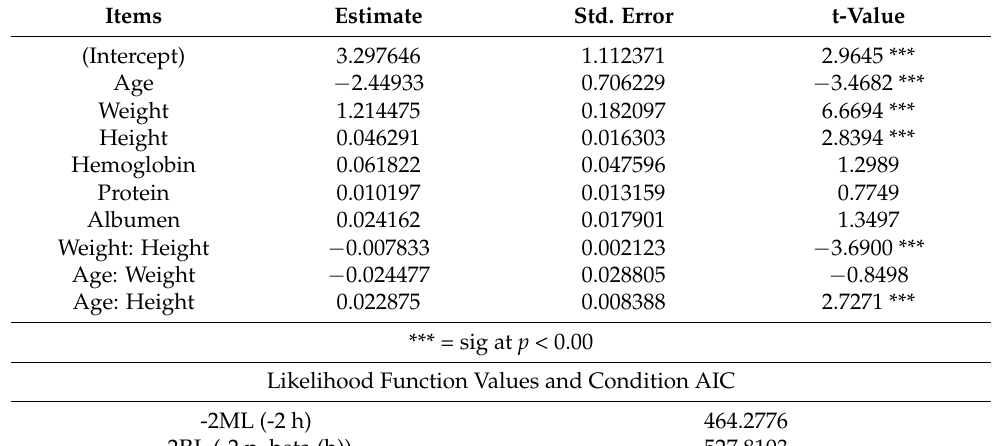
Table 3. Model estimates for Gaussian Generalized Linear Model (GLM).